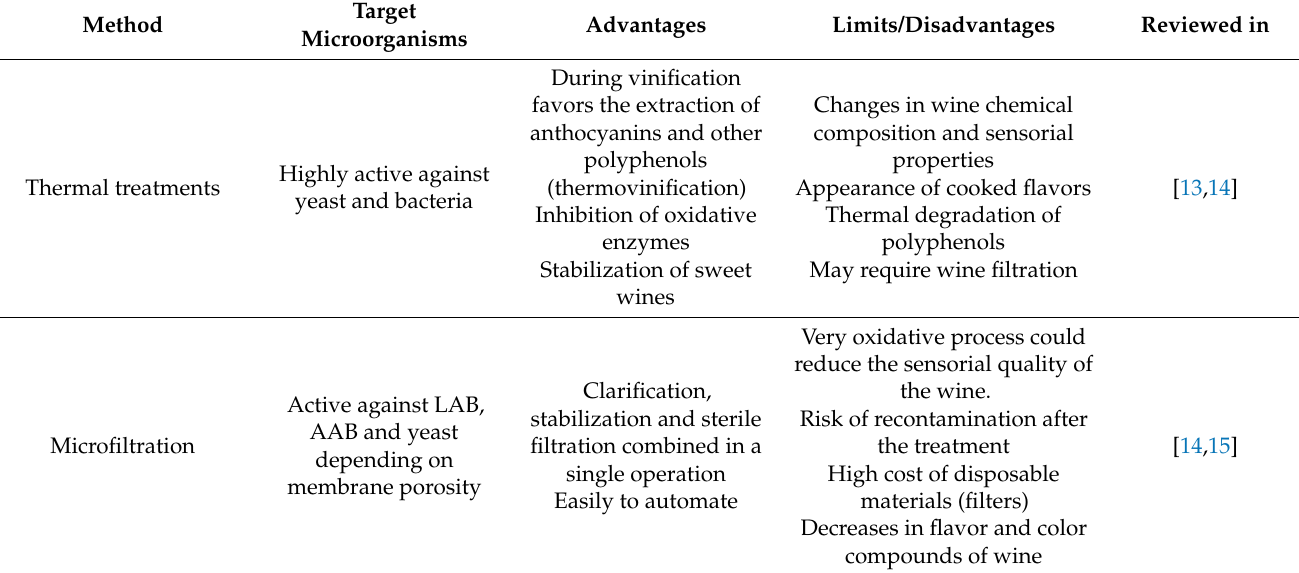
Table 1. Main physical methods used to replace/reduce SO 2 addition in